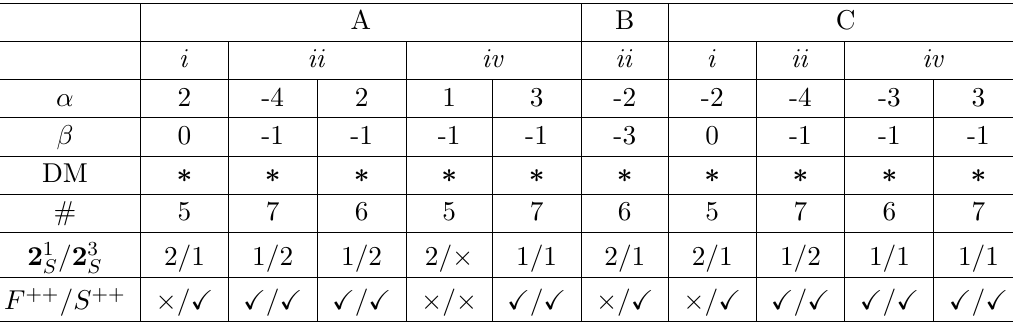
Table 12. The same as in table 10 for diagram 2.c of (cid:12)gure